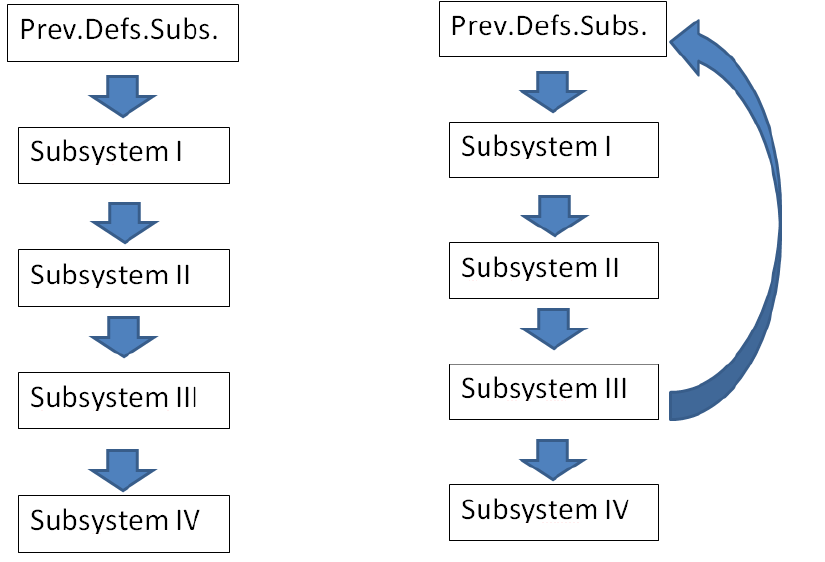
Figure 4. Example of perfect flow in the cascade of subsystems ( left ). Example of flow in the cascade of subsystems when Subsystem IIIa asks an “exercise electrocardiogram” to be carried out: when these data are obtained the knowledge extraction process is restarted ( right ).